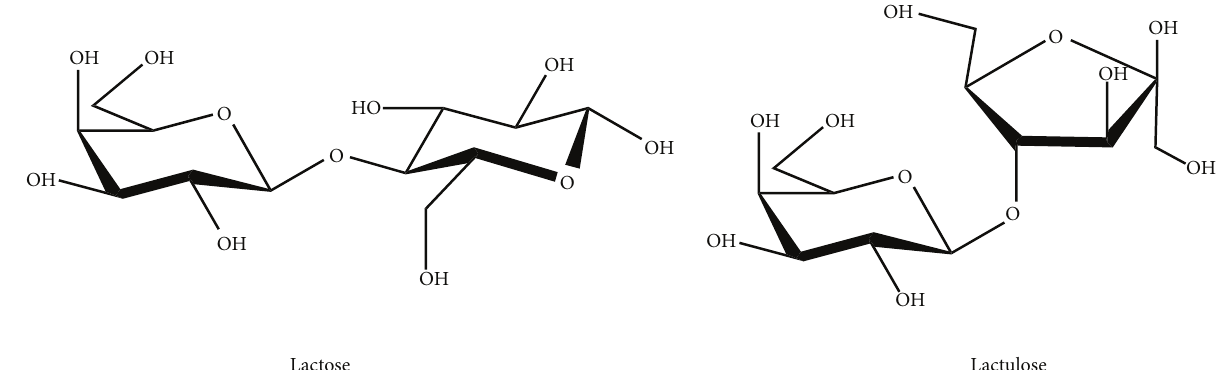
Figure 1: Basic structure of lactose and